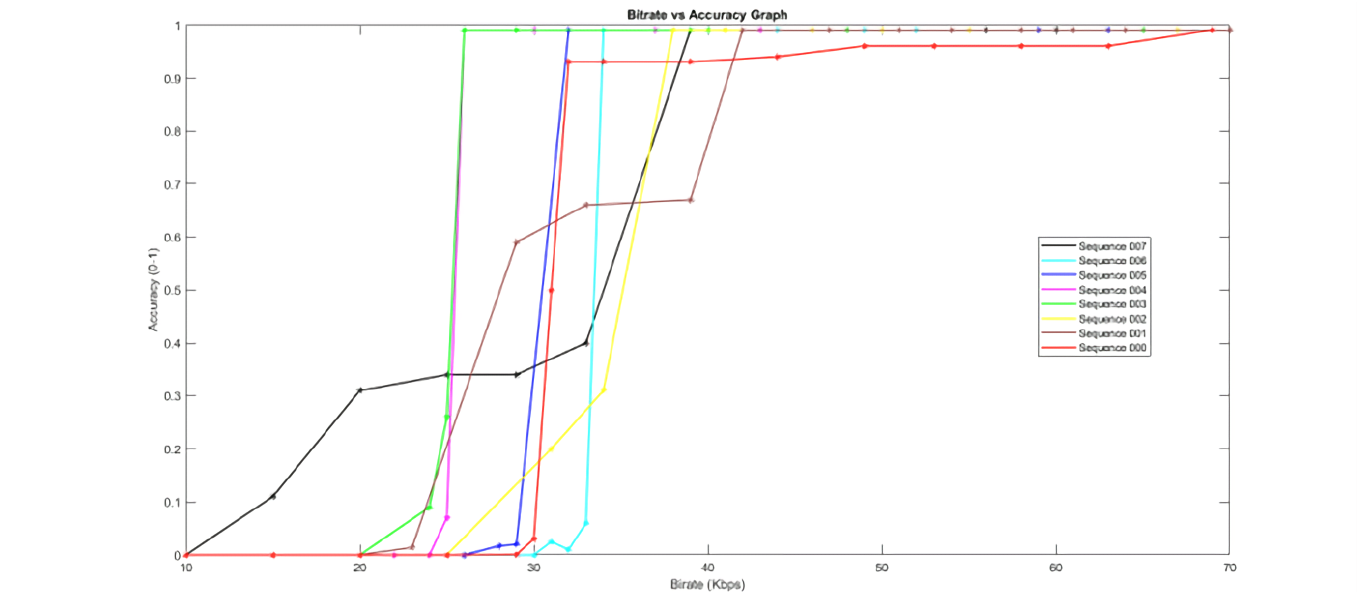
Figure 3. Bitrate vs. accuracy of video